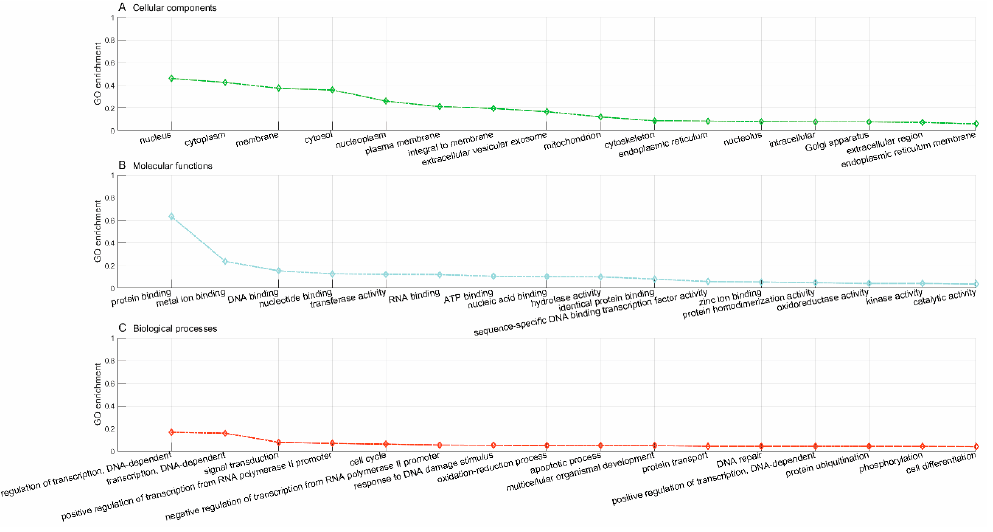
Figure 4. GO enrichment analysis of the known genes targeted by drug CIDm00004156.